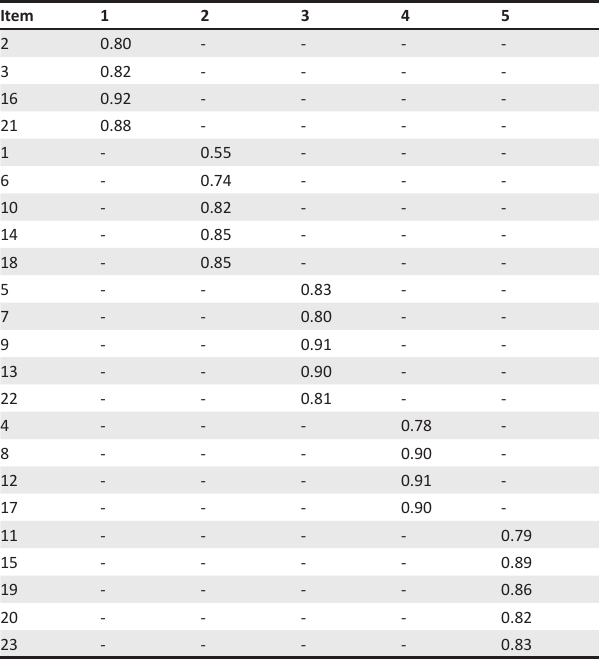
TABLE 4: Completely standardised solution LAMBDA-X.